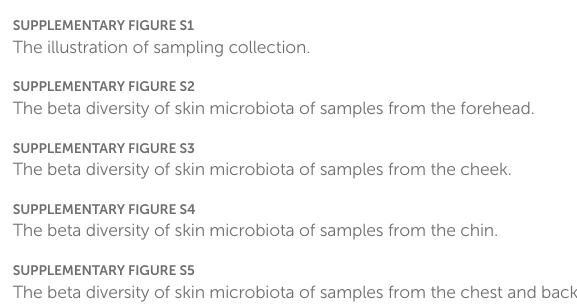
SUPPLEMENTARY FIGURE S1 The illustration of sampling collection. SUPPLEMENTARY FIGURE S2 The beta diversity of skin microbiota of samples from the forehead. SUPPLEMENTARY FIGURE S3 The beta diversity of skin microbiota of samples from the cheek. SUPPLEMENTARY FIGURE S4 The beta diversity of skin microbiota of samples from the chin. SUPPLEMENTARY FIGURE S5 The beta diversity of skin microbiota of samples from the chest and